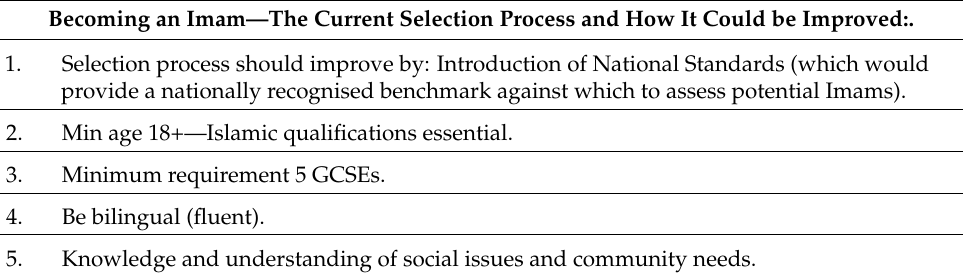
Table 3. Interpretative content analysis Delphi 3. Workshop question